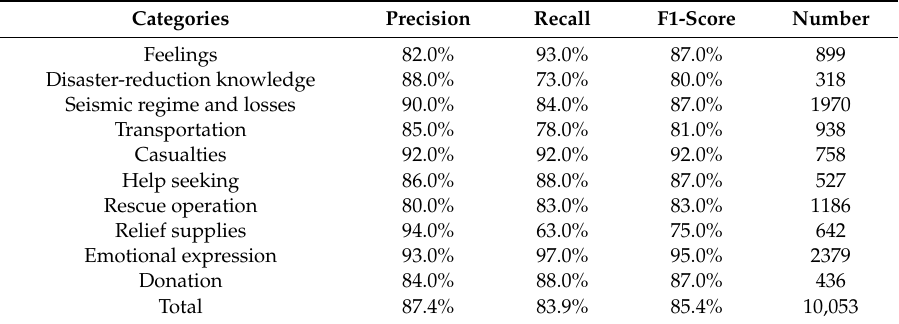
Table 2. Precision, recall, and F1-score values character-level CNN text